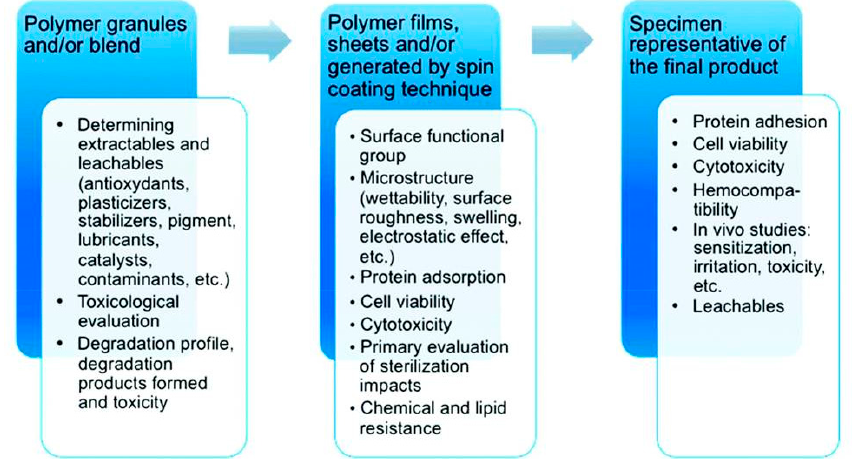
Figure 2. Sequential chemical, physical, and biological investigation steps of polymeric materials for biocompatibility assessment. Adapted from [18], with permission from © 2018 Royal Society of Chemistry.